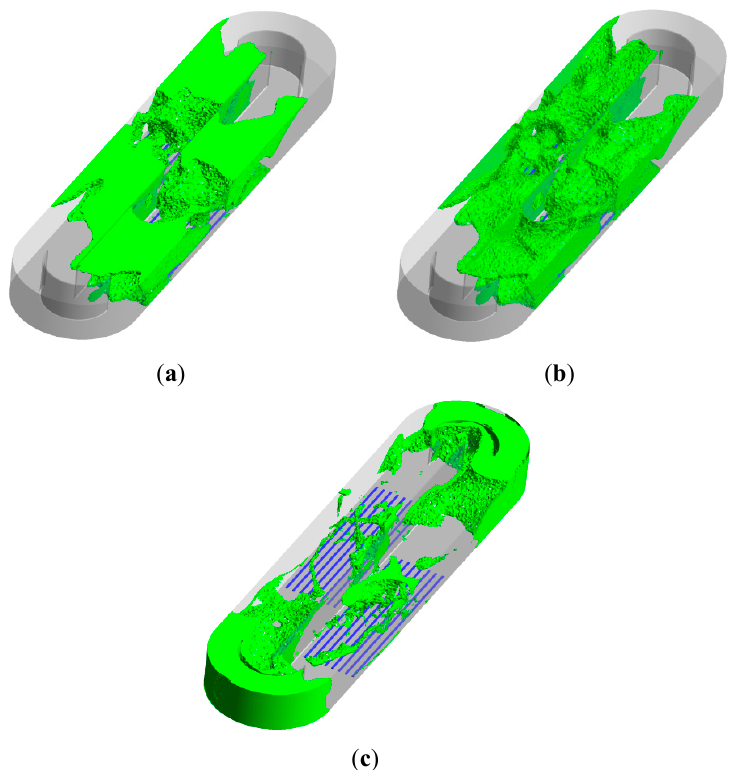
Figure 14. Water velocity isovolumes, ( a ) above 0.3 m/s; ( b ) 0.3 m/s; ( c ) below 0.1 m/s.